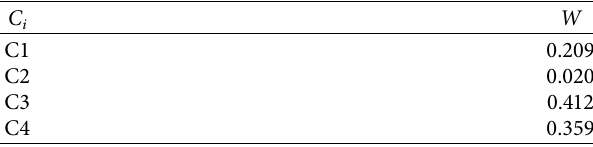
Table 10: Normalization of fuzzy vector weight value ( W ).